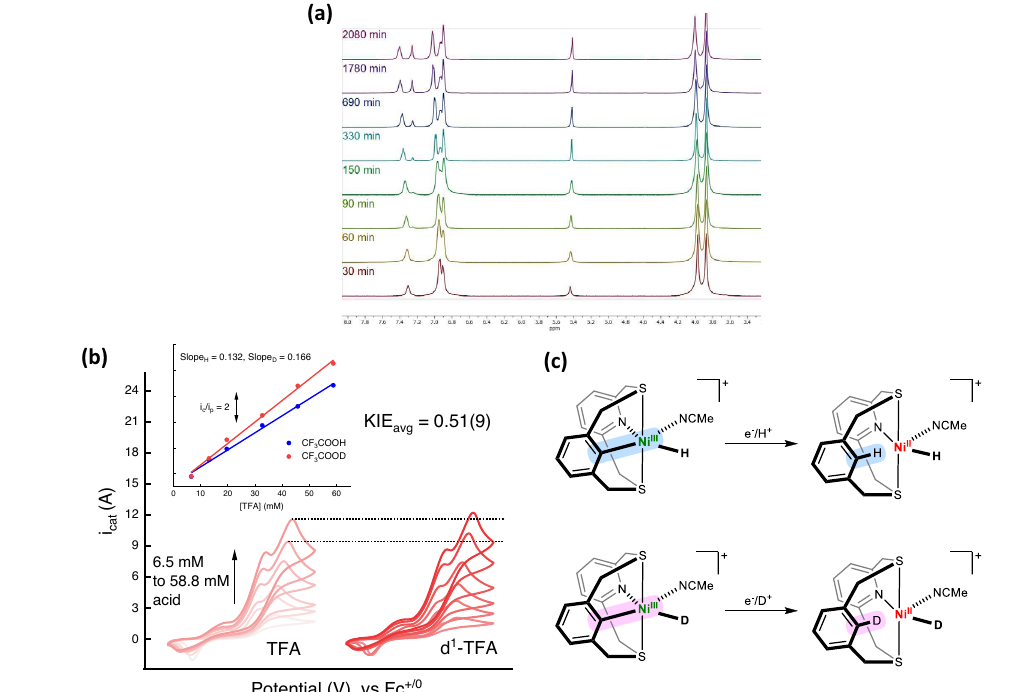
Fig. 6 | C – H activationand electrochemicalKIE measurements. a Growth of the NMR signal corresponding to the ipso C – H (~7.24ppm, singlet) bond when NCDS2 and NiOTf 2 weremixed togetherin 1:1CD 3 CN:CD 2 Cl 2 and heatedin aJ-Young NMR tube and heated at 80°C over the course of 3 days. b A representative example of anelectrochemical kinetic isotope effect(KIE) experiment. Titrations of CF 3 COOH or CF 3 COOD into a 0.1M TBAPF 6 /MeCN produced catalytic currents. These cur- rents were normalized by the i pc (Ni II/I ) under N 2 atmosphere at the same catalyst